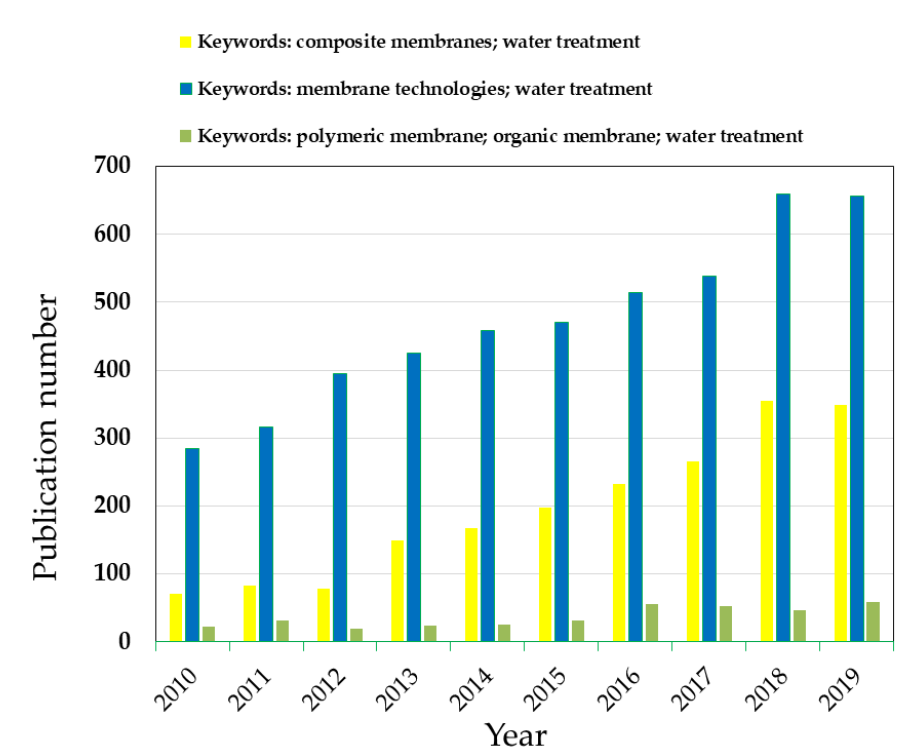
Figure 1. Publication record of using membrane technologies and composite membranes for water treatment over the last 10 years. Data acquired from Scopus (www.scopus.com) using the reported